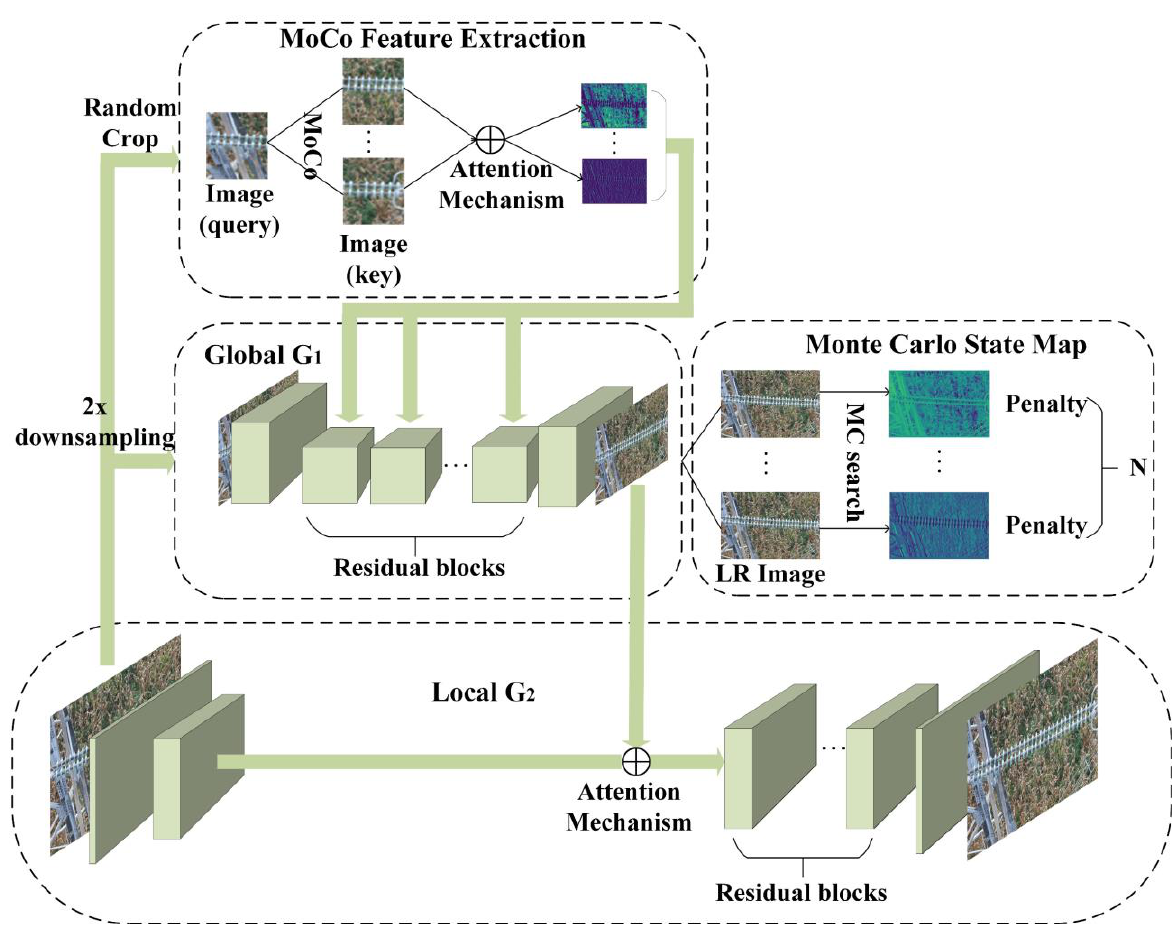
Figure 3. The multi-level generator consists of MoCo feature extraction, a global generator, a Monte Carlo strategy, and a local generator. Firstly, MoCo extracts the image ’ s feature and fed into the global generator ’ s residual layer. Secondly, the global generator is employed to generate LR. Next,